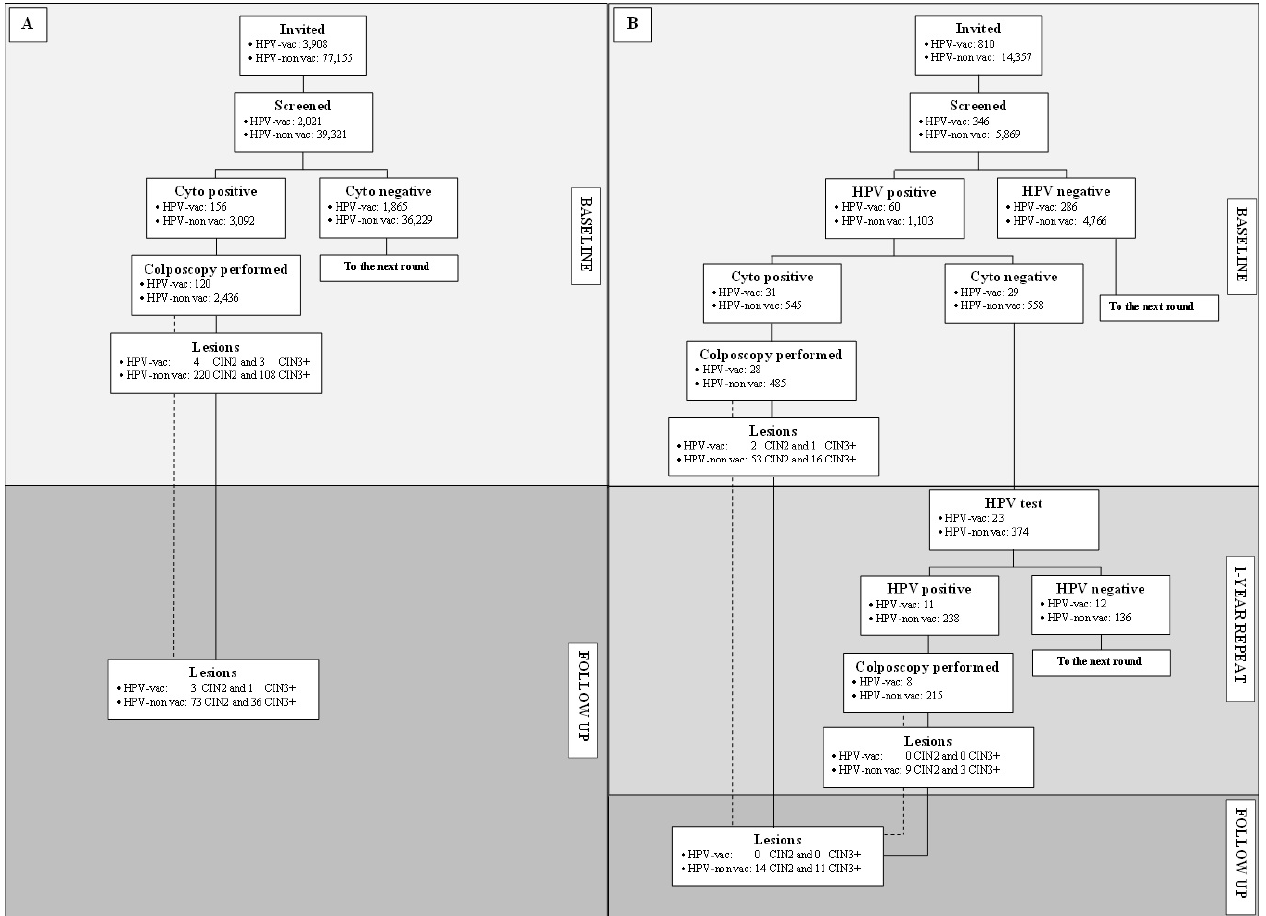
Figure 3. Flowchart of the study for women invited to cytology-based screening ( A ) or to HPV-based screening ( B ). During follow-up, one CIN3+ was diagnosed in HPV-vaccinated and 36 in non-vac- cinated women. Considering all the lesions detected by the end of the follow up, the rela- tive risk of CIN3+ for HPV-vaccinated was lower, although statistically non-significant (RR 0.5; 95%CI 0.2–1.5; p = 0.33). 3.5. Results of HPV-Based Screening Overall, 15,167 women were invited to screening with HPV test. Among the 6215 compliers, 346 were HPV-vaccinated and 5869 non-vaccinated (Table 3 and Figure 3). Overall HPV positivity was 18.7%: 17.3% for HPV-vaccinated and 18.8% for non-vac- cinated ( p = 0.54). Among HPV positives, triage cytology was positive in 51.7% (31/60) in the HPV-vaccinated and 49.4% (545/1103) in the non-vaccinated. Overall, 576 women were referred to colposcopy with a compliance of 90.3% and 90.0% for HPV-vaccinated and non-vaccinated, respectively. The detection rate of CIN3+ was 2.74‰ (17/6216) over- all, and similar for HPV-vaccinated (2.89‰) and non-vaccinated (2.73‰; p = 1). The PPV for CIN3+ at colposcopy was 3.3% overall, 3.6% in the HPV-vaccinated and 3.3% in the non-vaccinated ( p = 1). Among HPV+cyto- women who repeated the HPV test after one year, HPV positivity was non-significantly lower for HPV vaccinated than for non-vaccinated (47.8% vs. 63.6%; p = 0.51) (Figure 3). At one-year repeat, three CIN3+ lesions were found, all in the non- vaccinated group, and at follow-up three further CIN3+ were detected, again only in non- vaccinated. Considering the cumulative lesions detected at the baseline, at 1-year repeat and at follow-up, the relative risk of CIN3+ for HPV-vaccinated was lower, although the result was not statistically significant (RR 0.6; 95% CI 0.1–4.1; p = 1).